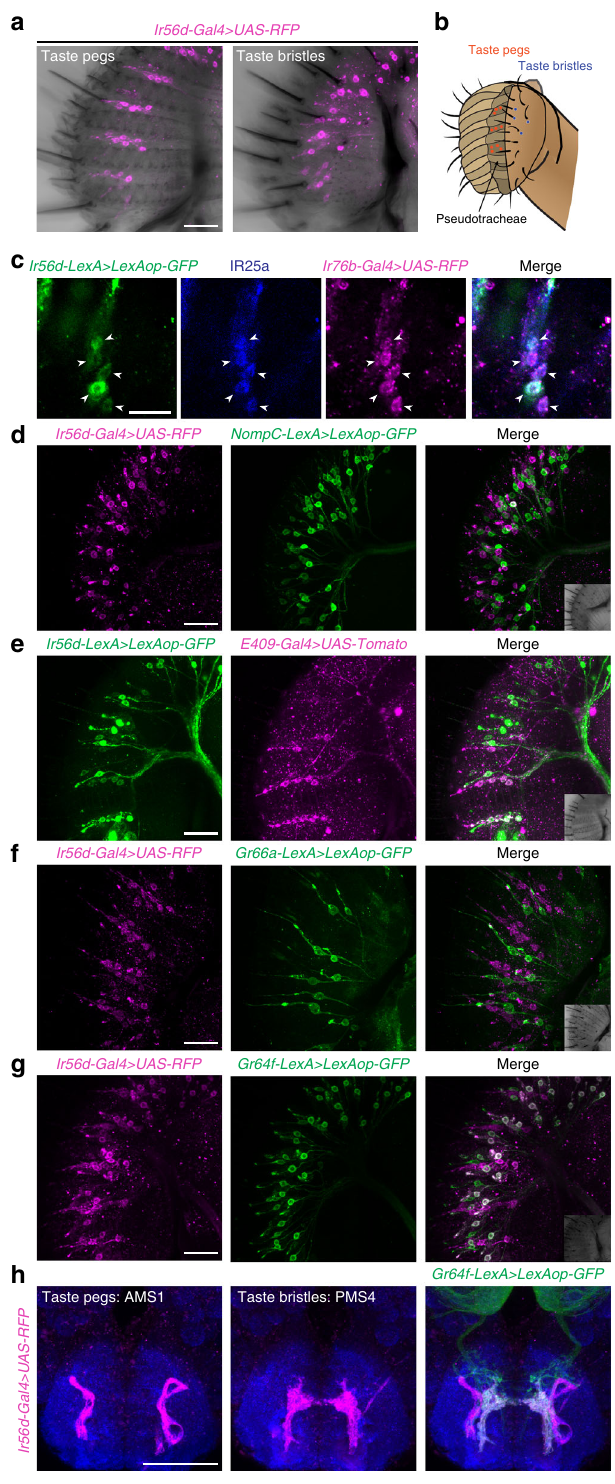
indicate that Ir56d subpopulations are both anatomically and physiologically distinct.